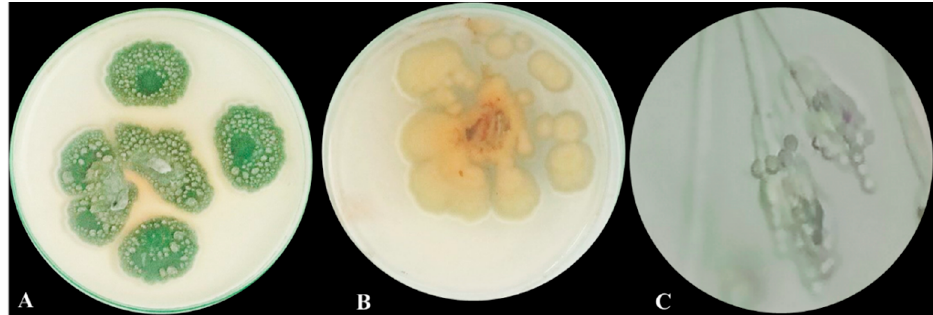
Figure 1. Morphological and microscopic examination of P . chrysogenum MZ945518. ( A ) Upper view of the fungal colony, ( B ) Dorsal view of fungal colony, and ( C ) Fungal conidiophore under light microscope.